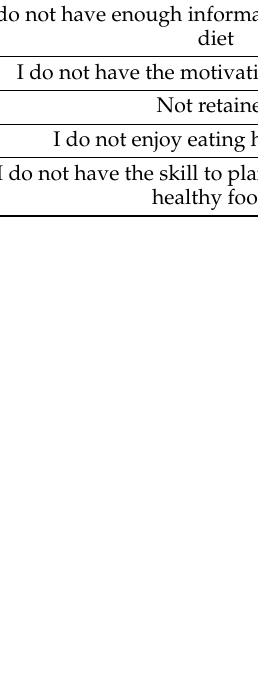
Table 3. Comparisons of perceived barriers scale scores by participant